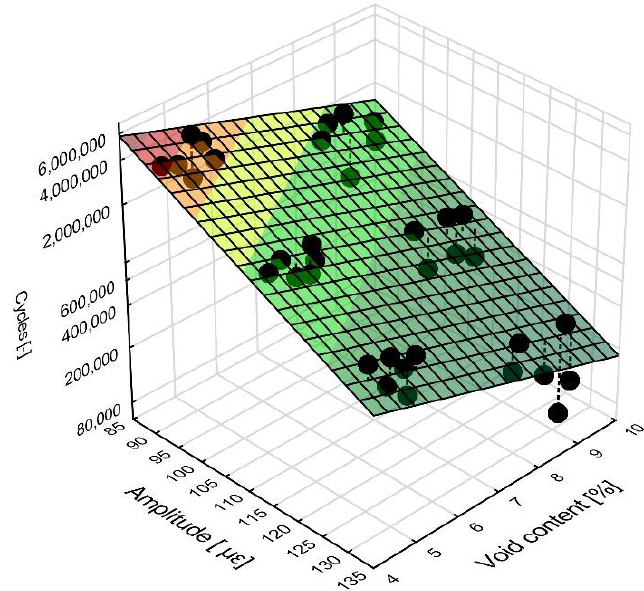
Figure 14. The relationship between the number of cycles, the strain amplitude, and the air void content showing the locations of the measurement points.